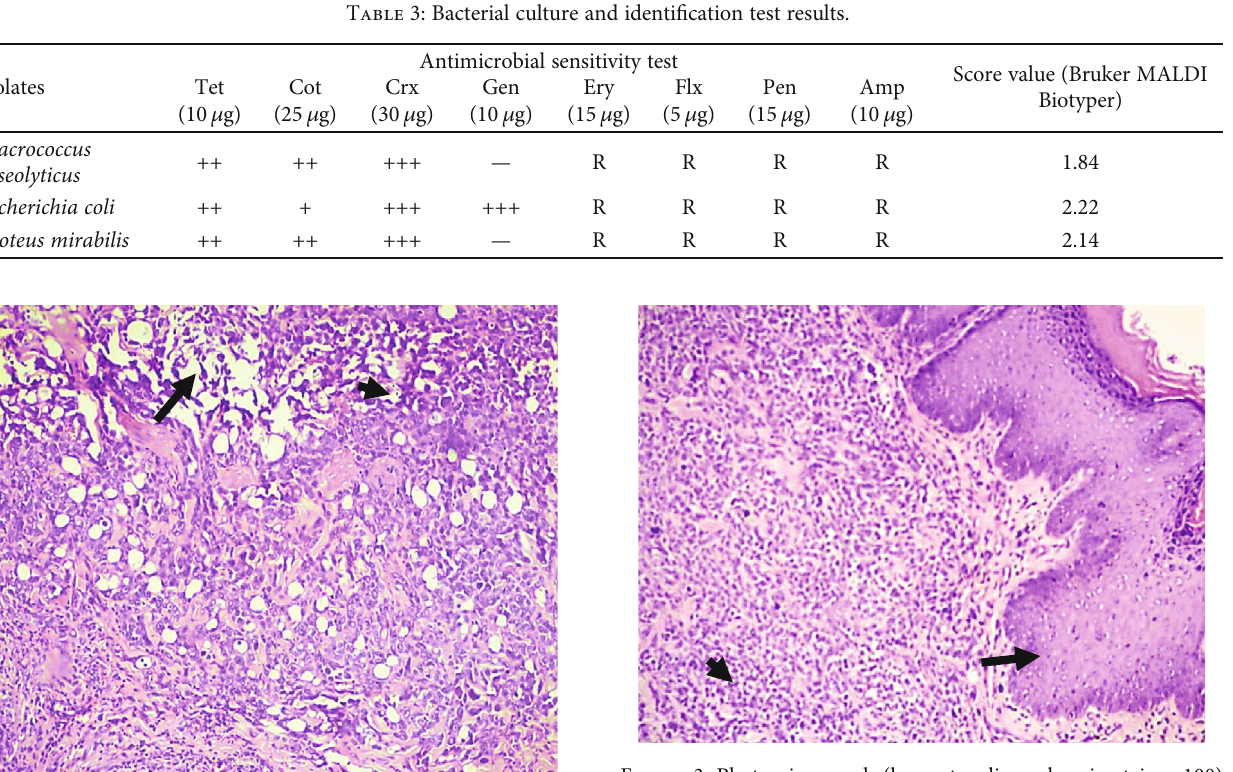
Figure 3: Photomicrograph (haematoxylin and eosin stain, × 100) demonstrating epidermal hyperplasia (arrow) and mass in fi ltration of the subcutis and dermis with bacteria and in fl ammatory cells